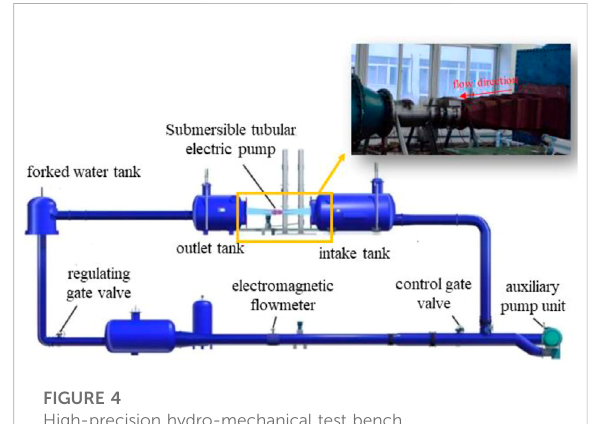
High-precision hydro-mechanical test